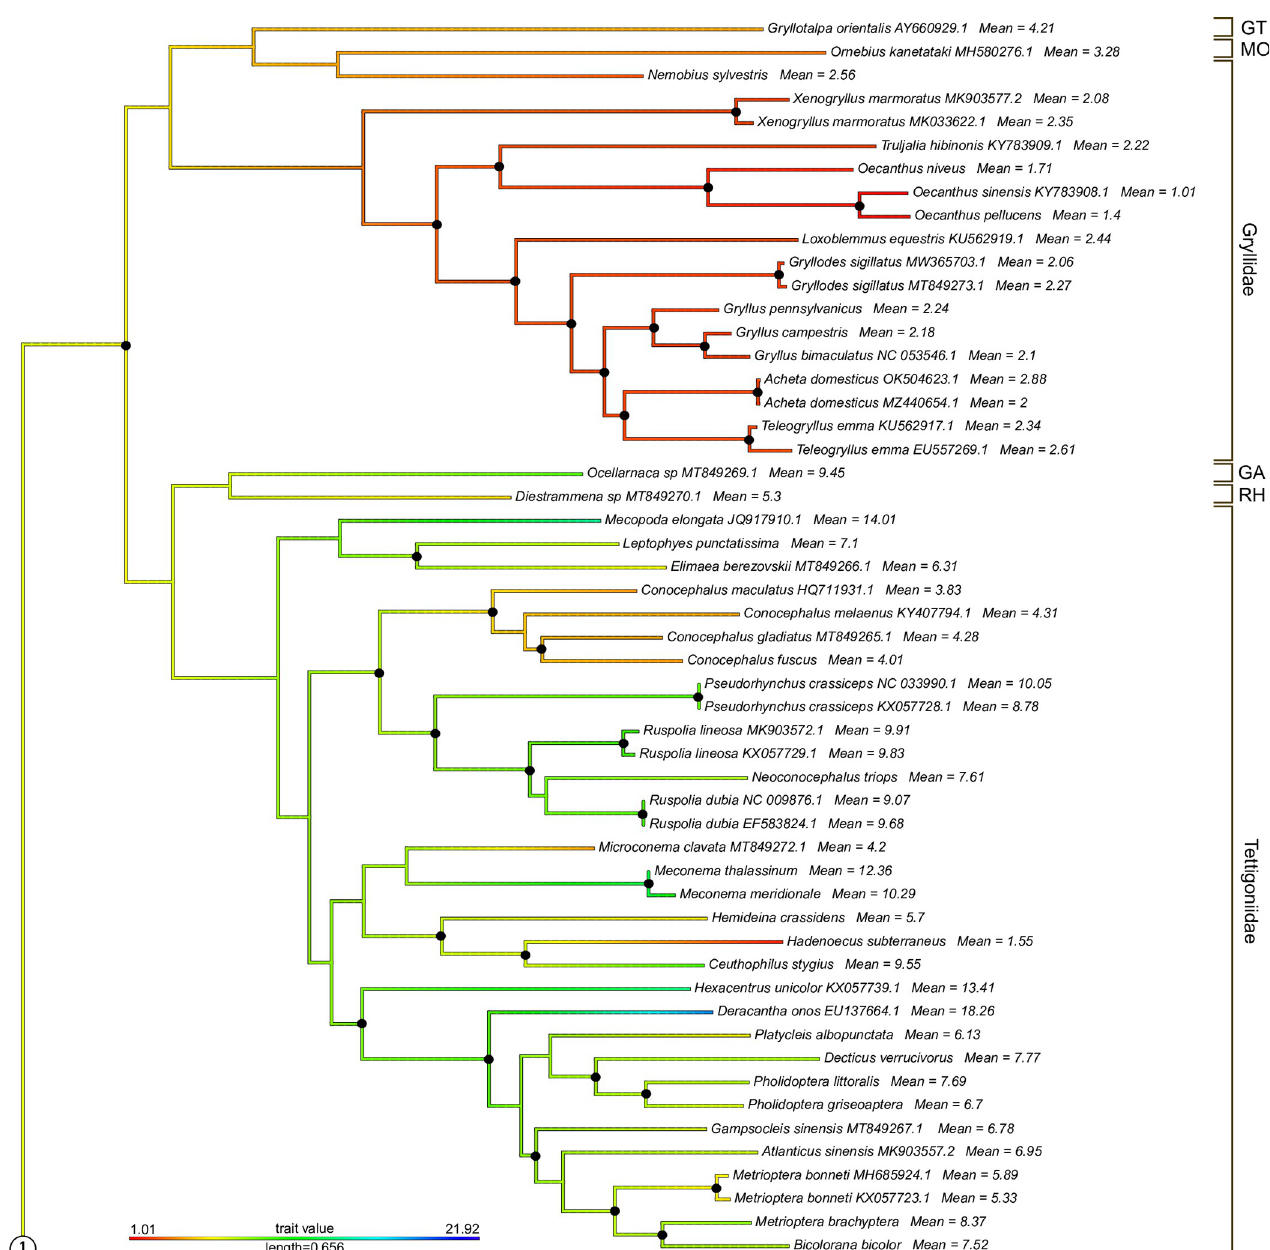
Fig 2. Maximum likelihood phylogenetic tree of the mitochondrial dataset of Orthoptera. Black dots on nodes represent Bootstrap support values of > 95%. Branch colors code genome size (see legend). Mean genome size values are given for all tips. The circled connector “1” links this tree to the tree in Fig 3. Abbreviations for higher taxa: GT = Gryllotalpidae, MO = Mogoplistidae, GA = Gryllacrididae, RH =